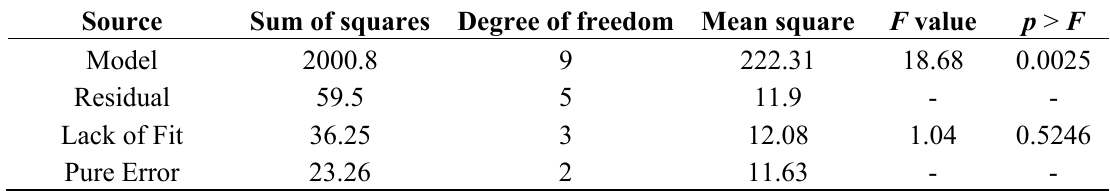
Table 5. ANOVA for the regression